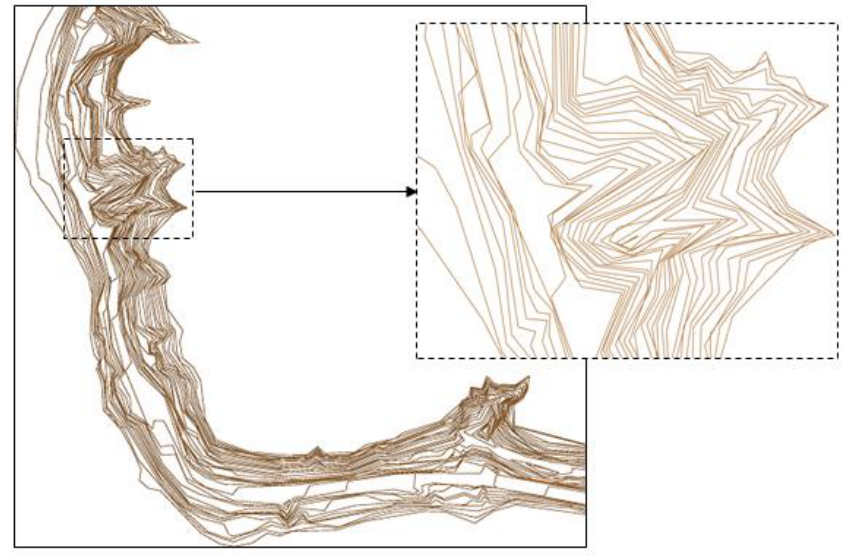
Figure 19. Simplified result with the orthographic division and DP-algorithm (parameter D = 40.0, composed of 1869 shape points).